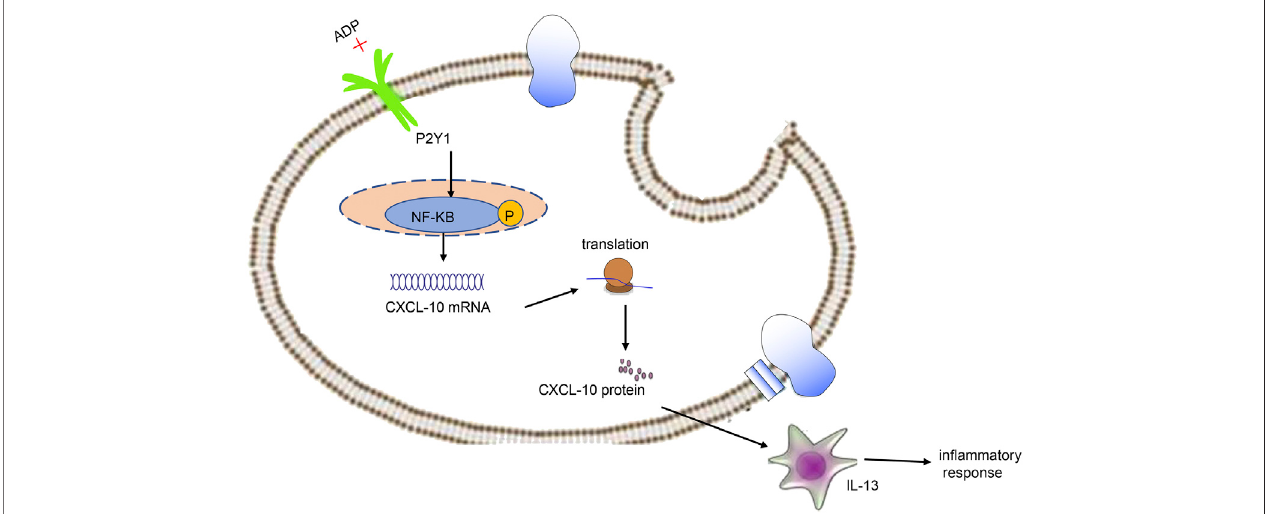
FIGURE 8 | Extracellular ADP triggers and maintains airway in fl ammation in asthma by activating P2Y1 receptor and promoting the secretion of CXCL10.